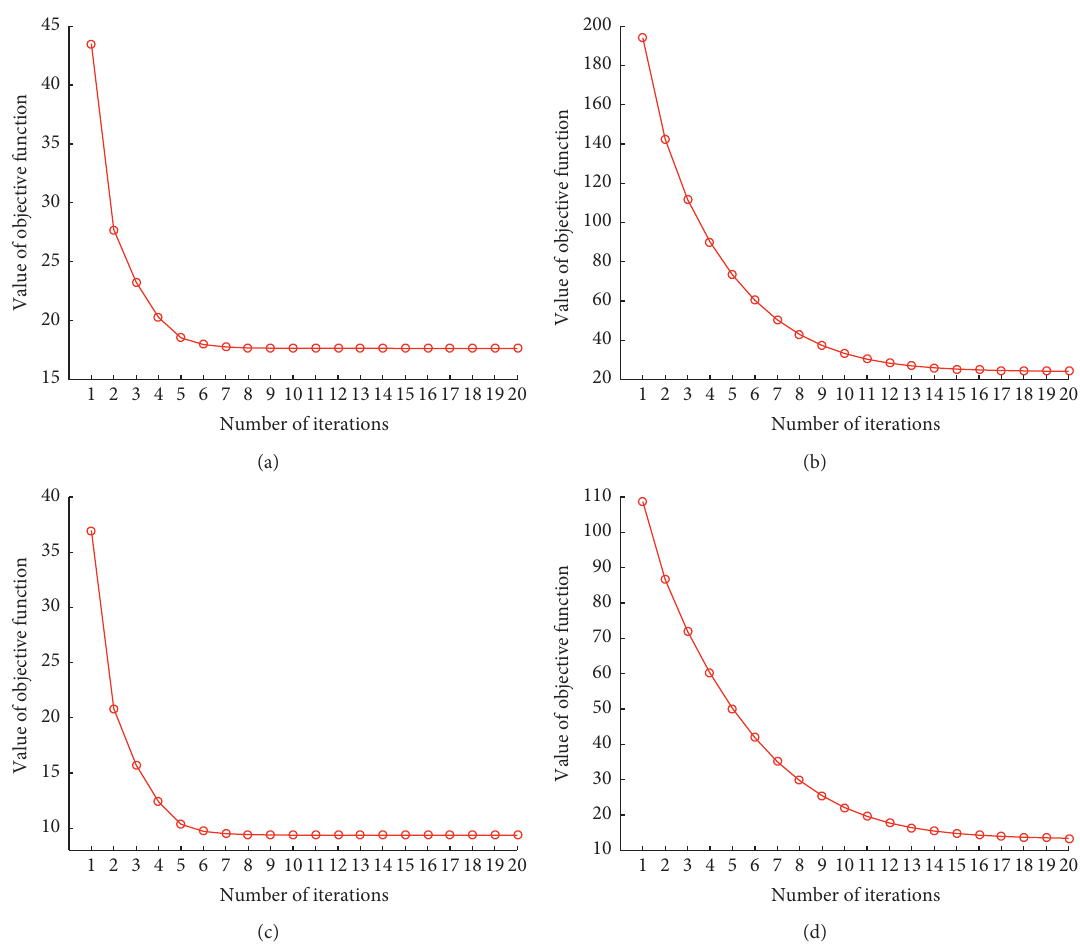
Figure 7: Convergence curves of the objective function value using Algorithm 1 on Wikipedia and Pascal datasets. The figure shows that the objective function value monotonically decreases until convergence by applying the iterative algorithm. (a) Image query on wiki-W. (b) Text query on wiki-W. (c) Image query on Pascal. (d) Text query on